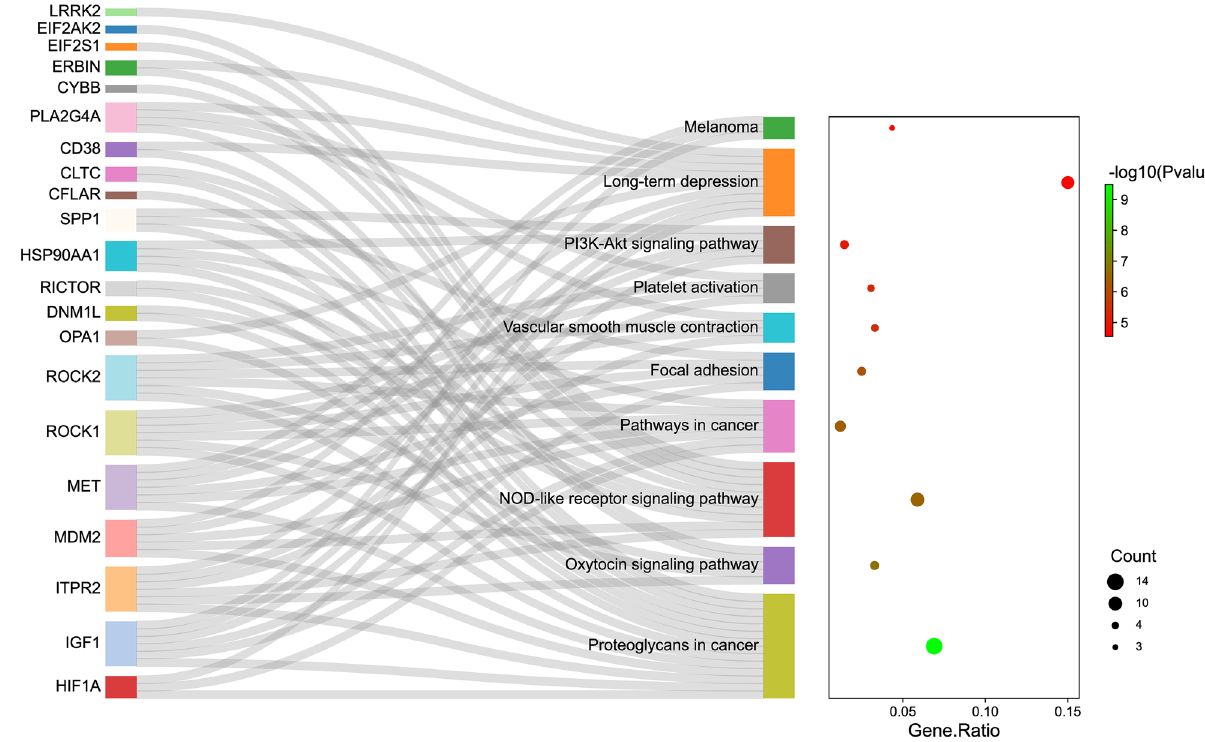
Figure 3: Sankey plot of KEGG enrichment analysis of DEARGs.